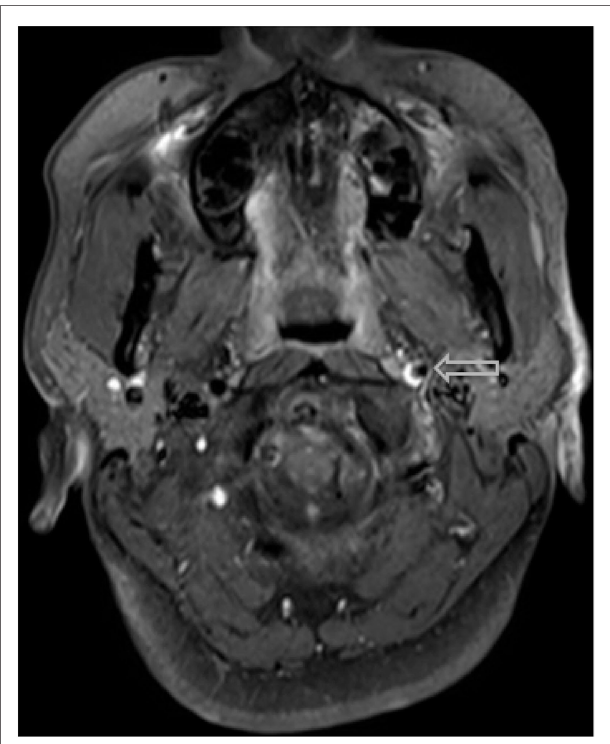
FIgURe 5 | A hyper-intense, crescent-shaped signal noting the presence of an acute thrombus within the cranial arteries on MRI